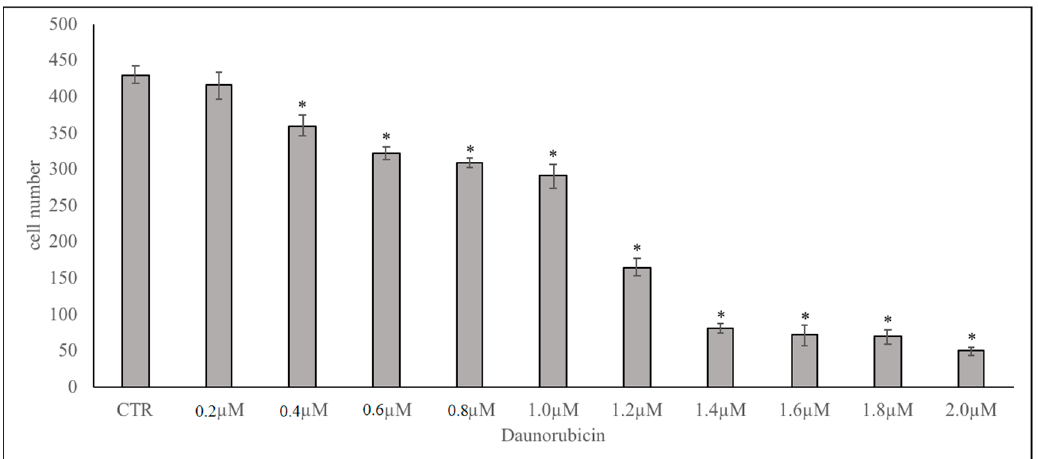
Figure 1. Dose-dependent effect of DNR on H35 cells: 300 × 10 3 cells were seeded and cultured with increasing doses of DNR from 0.2 to 2.0 μ M. CTR, control cells. Data indicate cell number after 24 h of culture and are expressed as the mean ± SD of three independent experiments. ∗ p < 0.05 versus CTR.